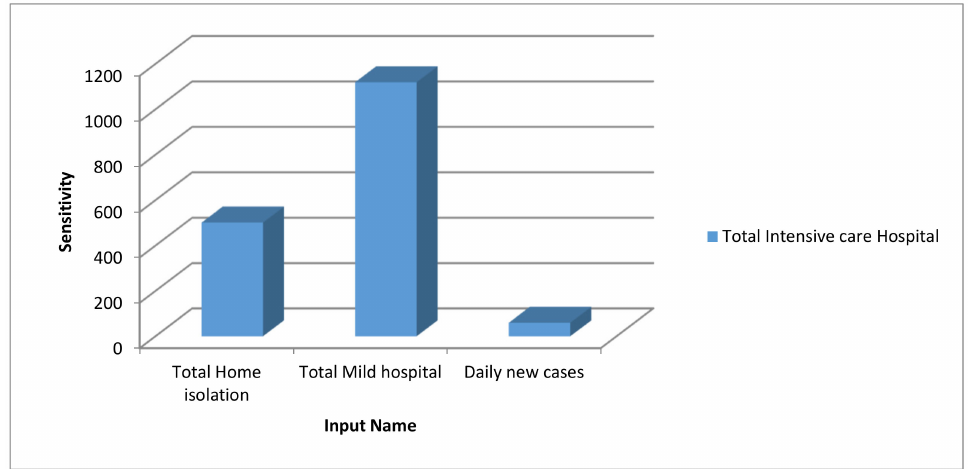
Figure 7. The impact of each variable on the result (Intensive care hospital), based on the training